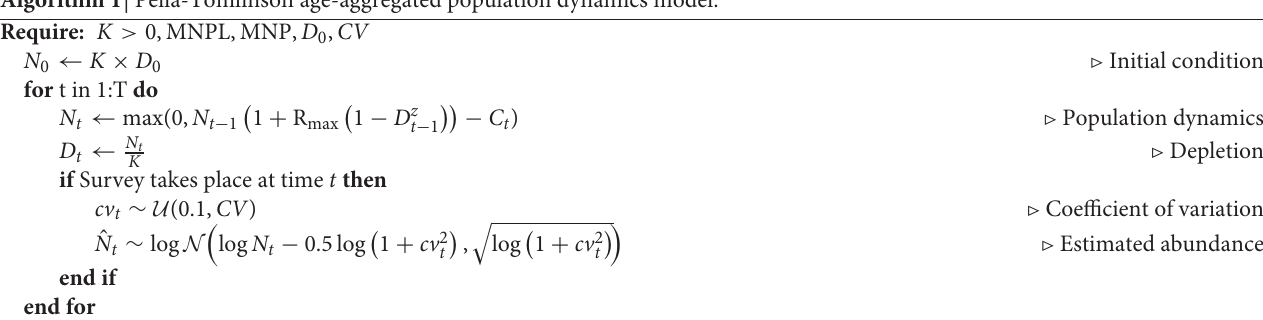
Algorithm 1 | Pella-Tomlinson age-aggregated population dynamics